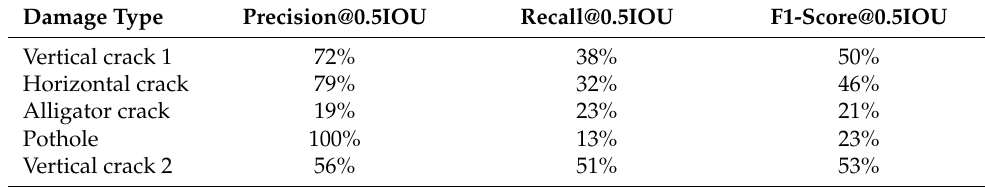
Table 7. Precision and recall of Model 4.